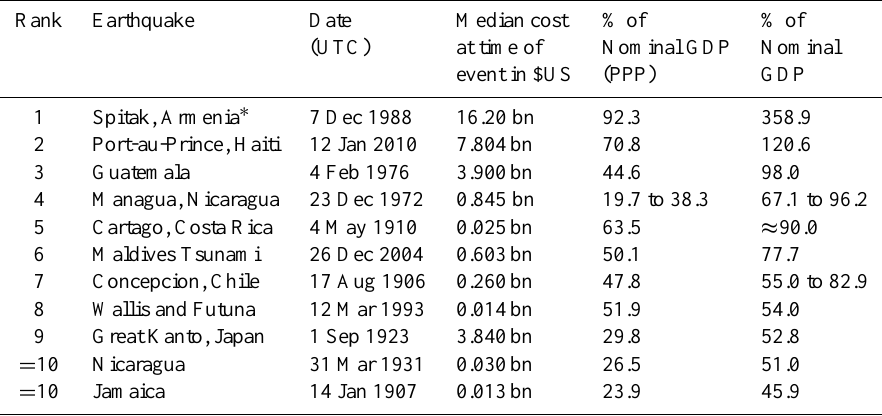
Table 5. The top 10 highest ranked earthquake losses since 1900 in terms of percentage of nominal GDP (both unadjusted and purchasing power parity) – Daniell et al. (2010a).